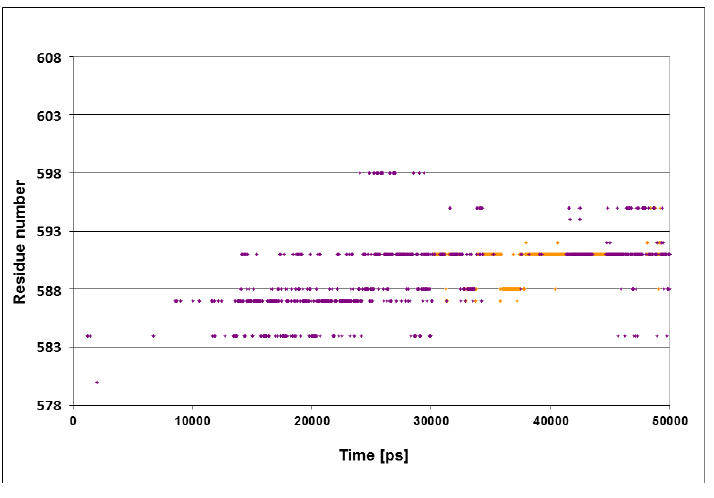
Figure 6. Spatiotemporal analysis of the interactions between residues on the lid, subjected to specific mutation (K577E) with the peptide. The dots describe the spatiotemporal analysis of the simulations of the complex of the mutated SBD (K577E) with the NR peptide. The color code for the distances is as in Figure